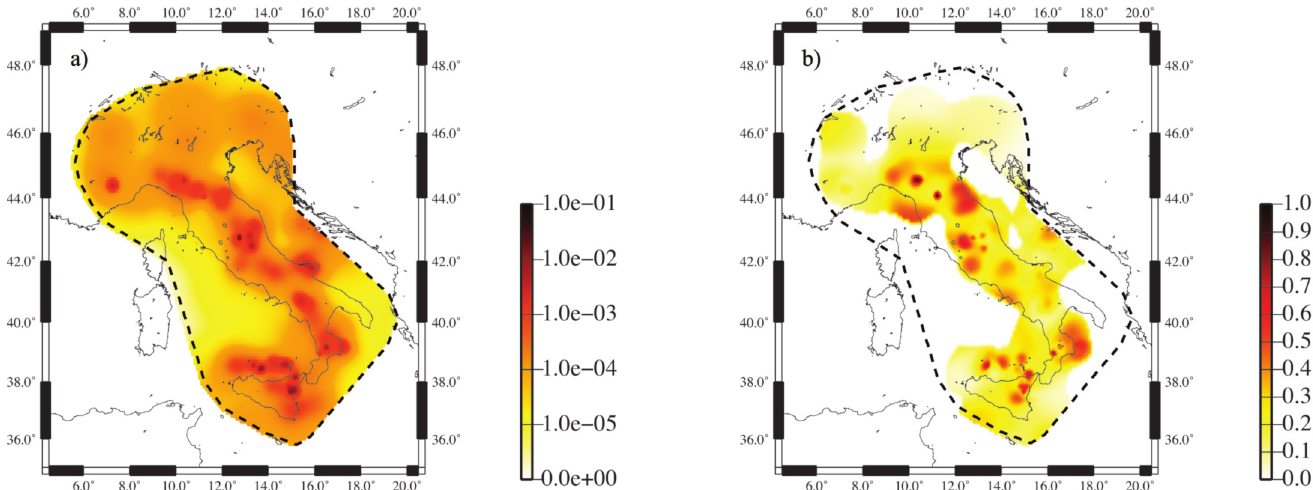
Figure 3. Maps of: a) the background seismicity rate o u ( x , y ); and b) the ratio between the triggered rate and the total seismic rate of the INGV bulletin learning dataset (April 16, 2005, to June 1, 2009; 2,100